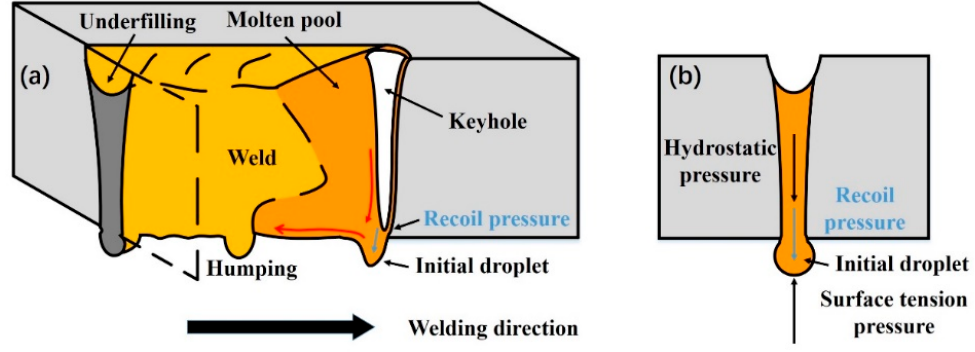
Figure 7. Schematic description of weld-root humping sound weld formation mechanism. ( a ) 3D isometric view; ( b ) Cross-section view isometric view; ( b ) Cross-section